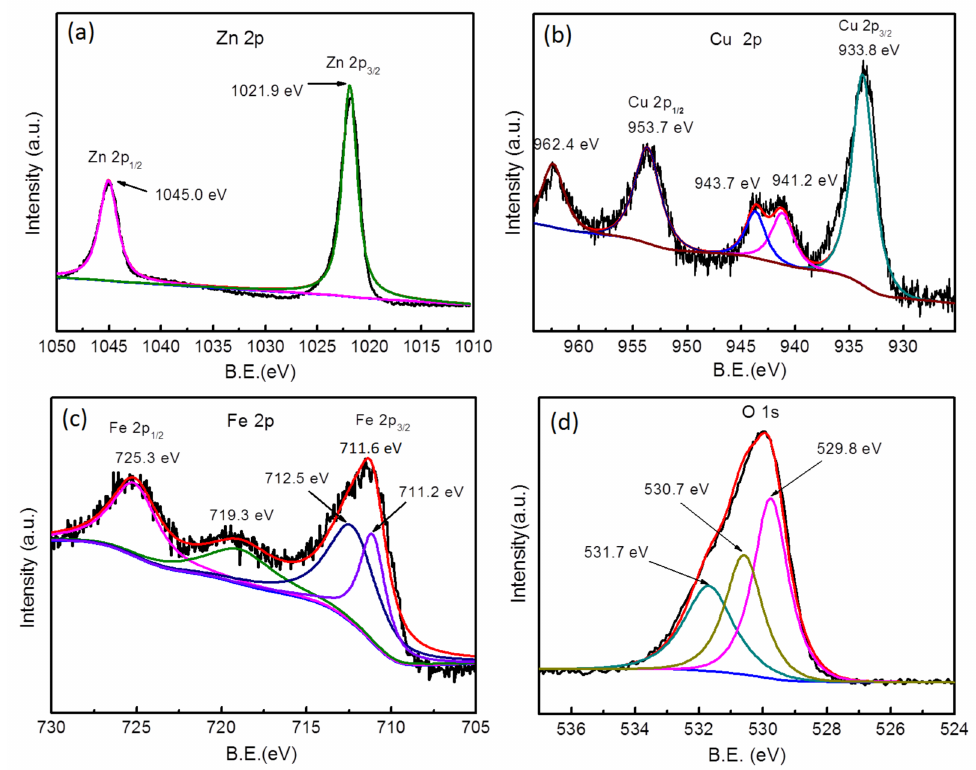
Figure 3. Core-level XPS spectra for ( a ) Zn 2p, ( b ) Cu 2p, ( c ) Fe 2p and ( d ) O 1s for the ZnO/CuOZnFe 2 O 4